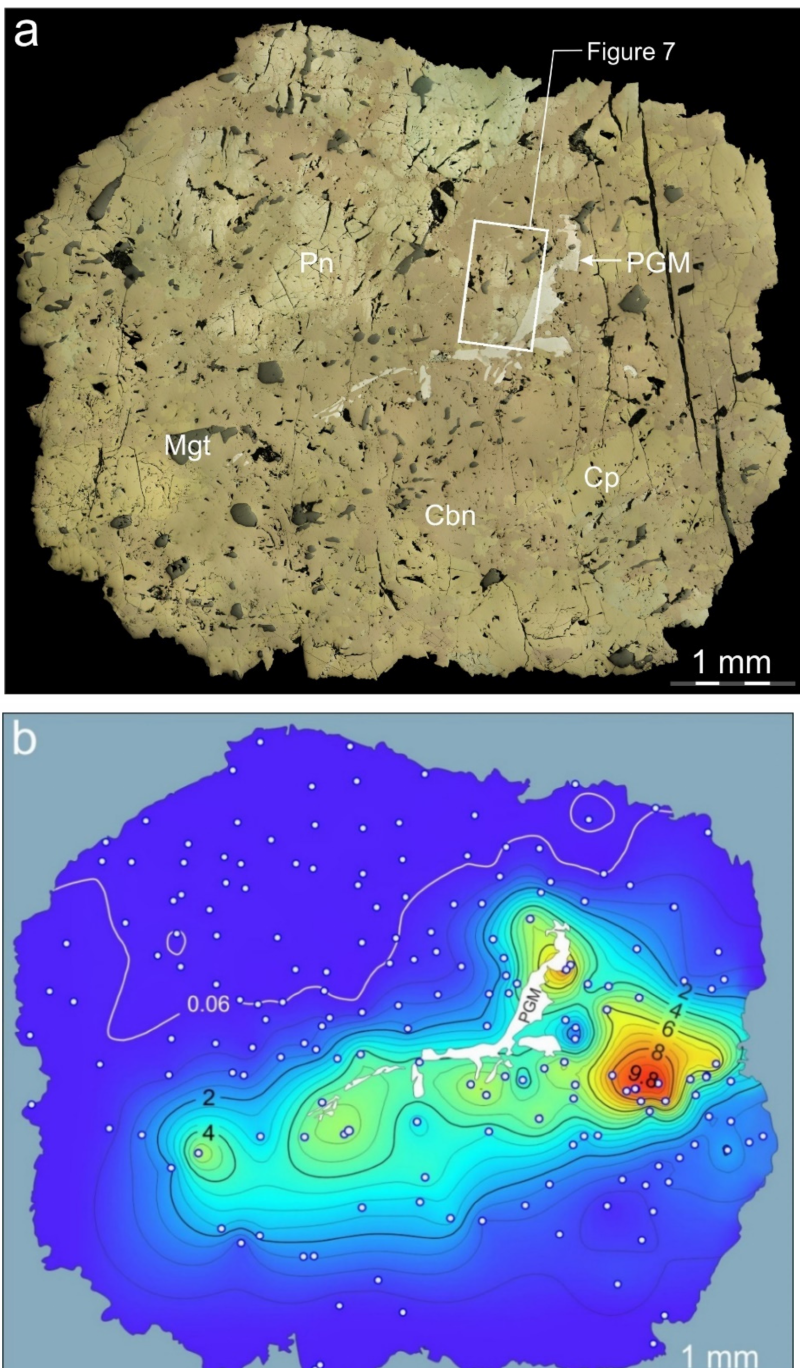
Figure 6. Distribution of Pd content (wt.%) in fine grains of pentlandite in cubanite ore (sample 32 − 11, depth 76.5 m). ( a ) The polished section in reflected light. Nicols are not completely crossed; ( b ) Contour map showing Pd concentrations (wt.%) in small grains of pentlandite. The white isoline (white) labeled as 0.06 corresponds to the lower detection limit for Pd in Pn imposed by the micro- probe. White dots represent the points of analyses. Abbreviations: Cbn—cubanite; Pn—pentlandite; Cp—chalcopyrite; Mgt—magnetite; PGM—multiphase grain of platinum group